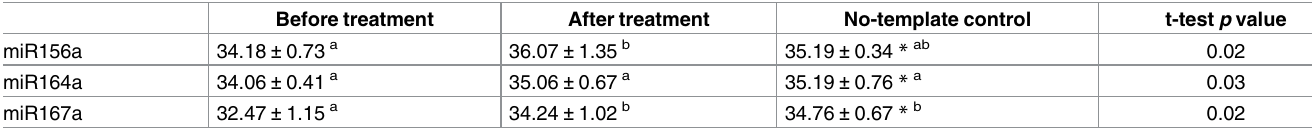
Table 5. Liver miRNA amplification cycle numbers. Before